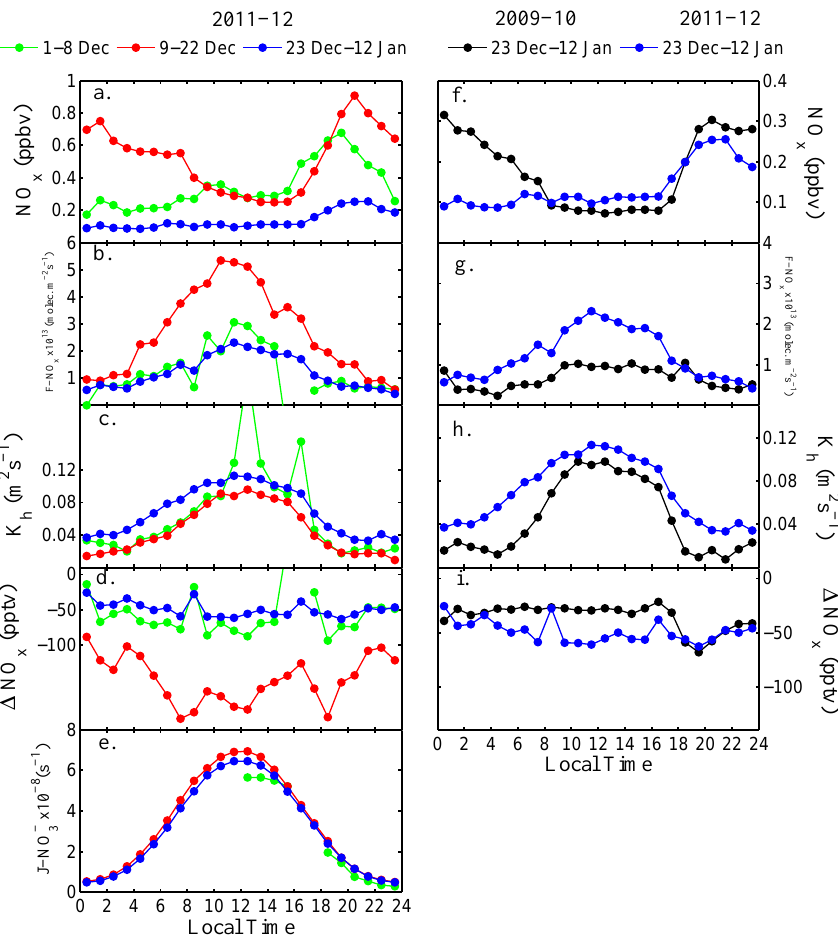
Figure 6. Observed median diurnal cycles during selected intervals in (a–e) 2011–2012 (referred to as periods II–IV in Table 2, Figs. 1, 7) and (f–i) 2009–2010. Shown are (a, f) NO x mixing ratios at 1m, (b, g) NO x flux ( F NO ) between 0.01 and 1m, (c, h) the turbulent diffusion x coefficient of heat ( K h ) at 1m, (d, i) the difference in NO x mixing ratios ( (cid:49) NO x ) between 1.0 and 0.01m, and (e) the 2 π downwelling nitrate photolysis rate coefficient ( J ). Note comparable observations of J are not available for NO − 3 NO − 3